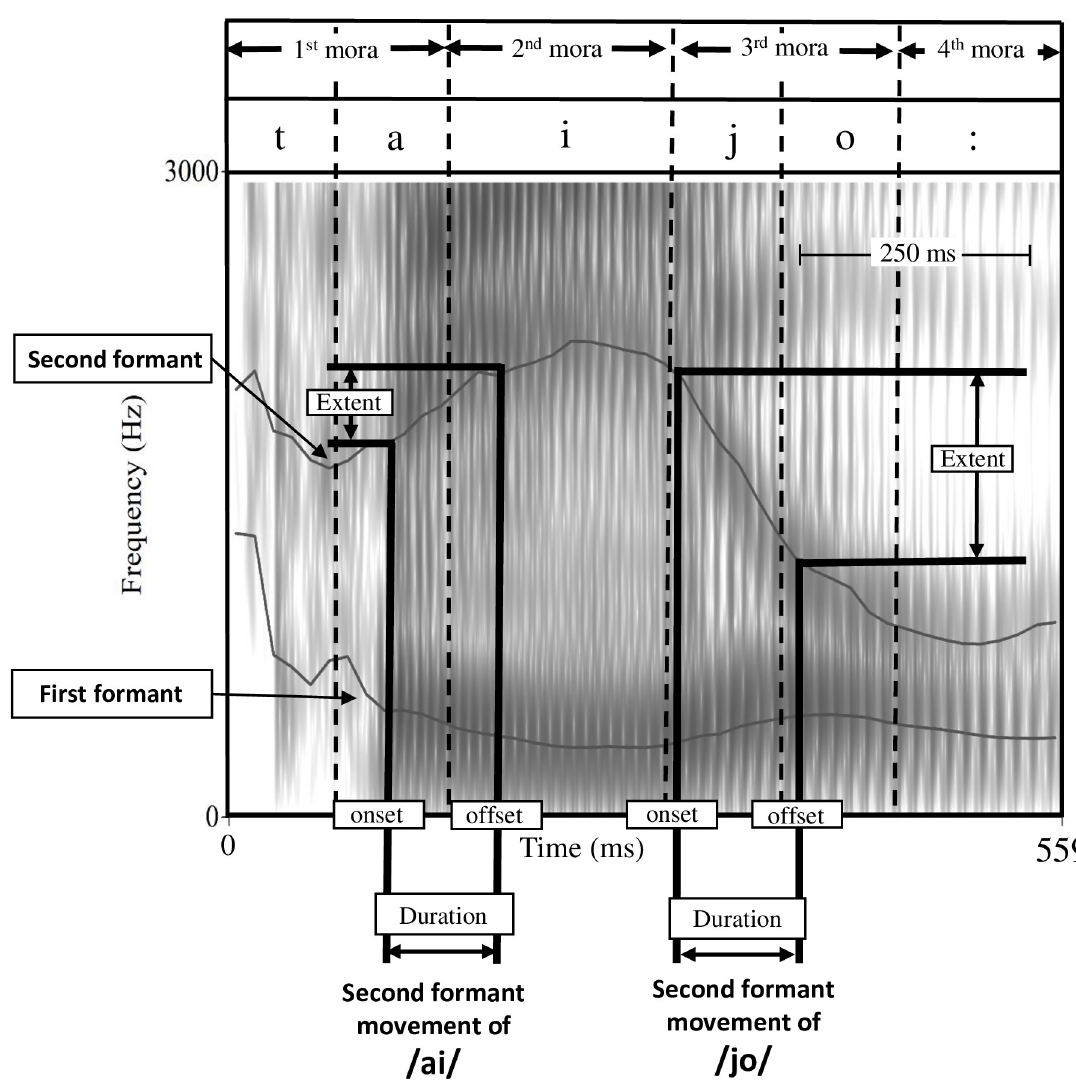
Fig 2. A spectrogram of the word /taijo:/ produced by a man with stroke and mild unilateral upper motor neuron dysarthria. This figure illustrates a major two vowel sequence and semivowel F2 movements in /ai/ and /jo/. The black lines running through the estimated centers of the first and second formants (F1 and F2) illustrate the formant tracing. Duration is the time interval of the F2 movement. Extent is the range of frequency change in the F2 movement. The F2 movement for each syllable is determined by a change in frequency of at least 20 Hz during a 20 ms period, not including the relatively stationary portions before and after the